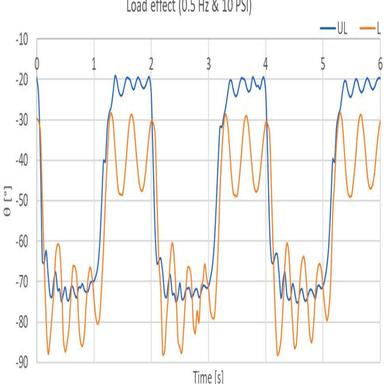
Radius – pressure effect (7 Hz & UL).